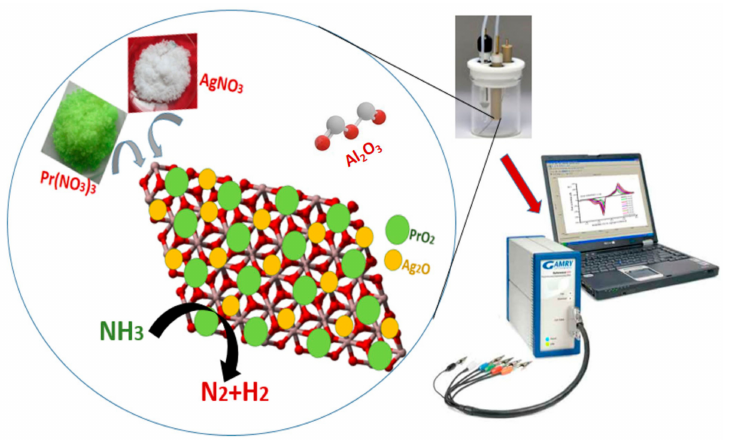
Figure 1. Graphical abstract elucidating the experimental, mechanistic and electrochemical